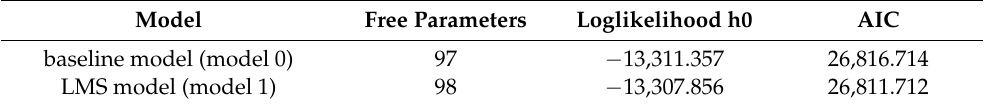
Table 6. Model comparison.